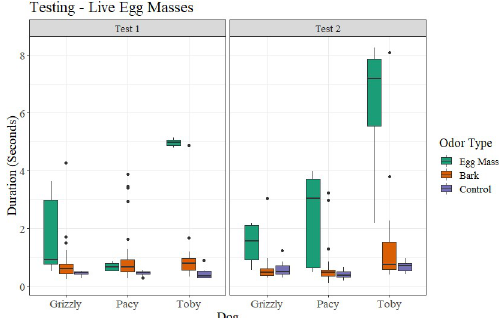
Fig 11. Duration that each dog spent at each port by what was in each port (either egg masses, bark, or controls) for live spotted lanternfly egg masses during the two double-blind testing sessions, where each spotted lanternfly egg mass presented was novel and paired with novel bark